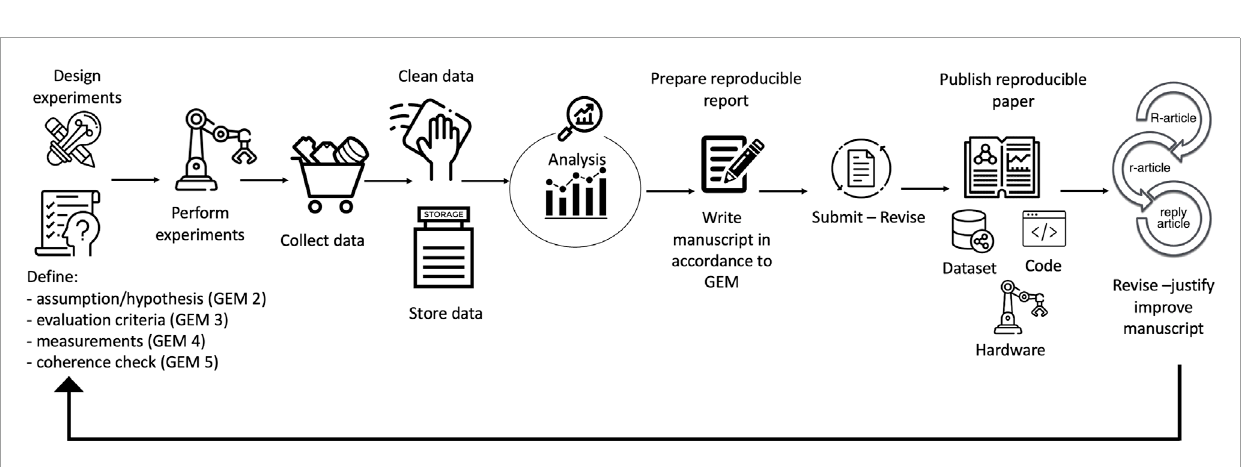
FIGURE 2 Reproducible research lifecycle: to have a fully reproducible paper, when the experiments are designed in accordance with the GEM guidelines, it is important to respect the following criteria. GEM 2: Are the system assumptions/hypotheses clear? GEM 3: Are the evaluation criteria spelled out explicitly? GEM 4: What is being measured and how? The claims based on the experiment and performance evaluations should be supported by measurable quantities. GEM 5: Do the methods and measurements match the criteria? After those steps, experiments are performed, and data are collected, cleaned, stored, and analyzed. The written manuscript should follow the GEM guidelines and have a clear and detailed description of all the information needed to reproduce the presented work. It is important to share, together with the paper, all the information necessary to reproduce the experimental work, i.e., the dataset, source code, and details about the hardware. The published reproducible experimental paper (R-article) will follow a new lifecycle and be eventually reproduced by other researchers in a replication article (r-article). The authors of the original R-article can then reply to the r-article with a reply article (Bonsignorio, 2017). From the published papers, new experiments can be designed and